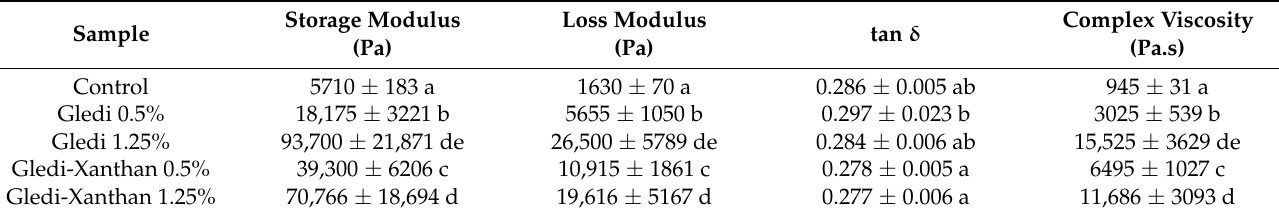
Figure 1. Rheograms for all studied samples. ( a ) Storage and loss moduli, ( b ) Complex viscosity, ( c ) tan δ . Table 2. Rheological parameters of gluten-free